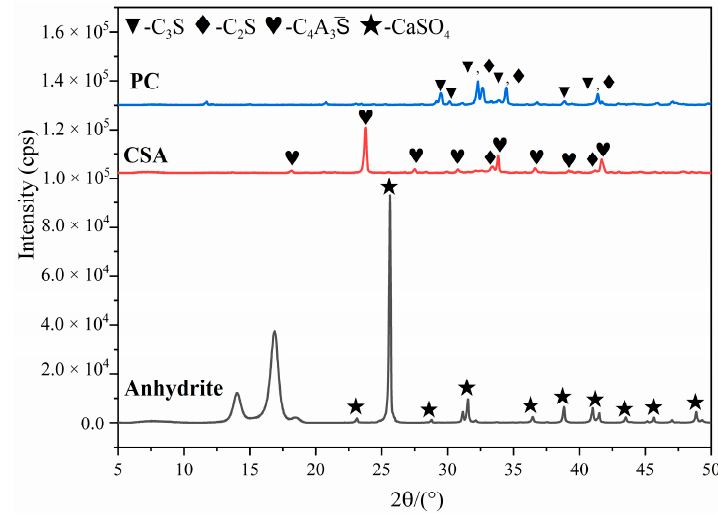
Figure 1. XRD patterns of raw materials.